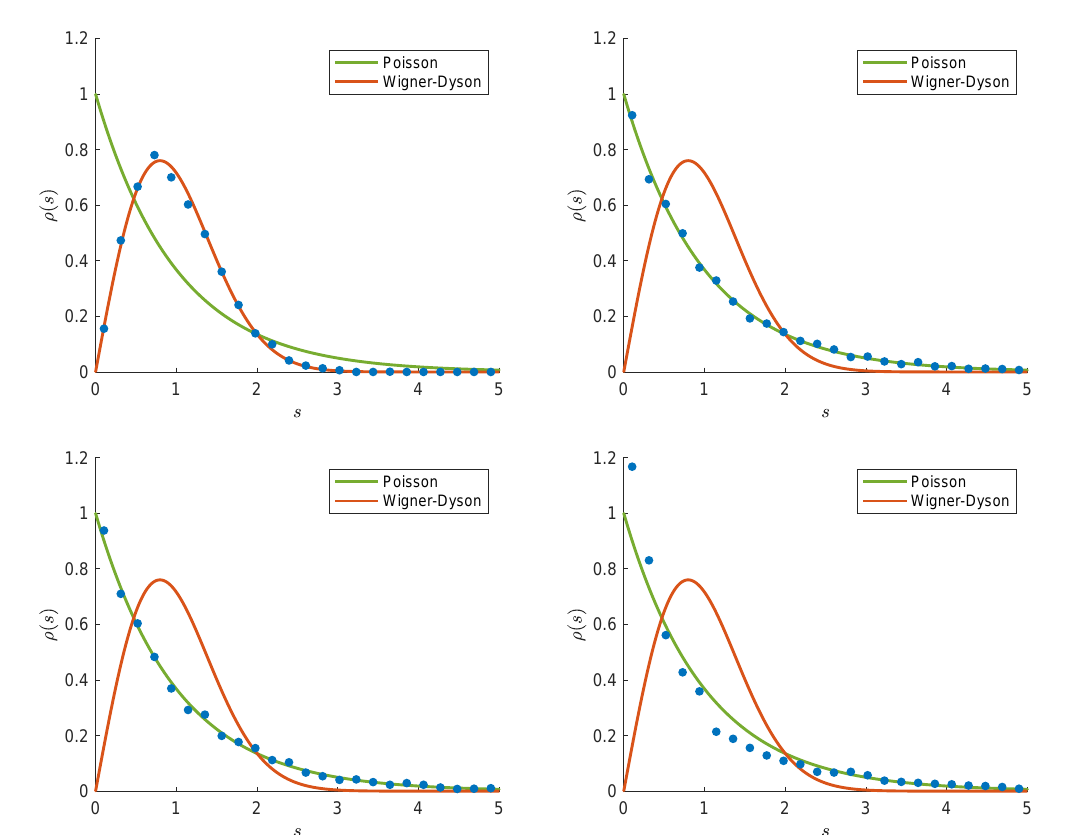
Figure 5: Unfolded level spacing statistics for the block ( N , M ) = ( 30,30 ) for (top left) a realization of a random resonant Hamiltonian; (top right) truncated Szeg˝o system; (bottom left) δ -deformed Szeg˝o system with δ = 1 / 2; (bottom right) α - deformed Szeg˝o system with α = 1. The last model displays a more pronounced peak at small level spacings than the Poisson distribution. The likely origin of this feature is the proximity of this system to the original GG Hamiltonian (5.9), which has many exact degeneracies in its purely integer energy